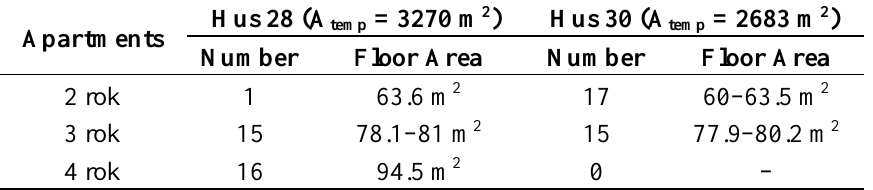
Table 2. Type of apartments in the Portvakten Söder